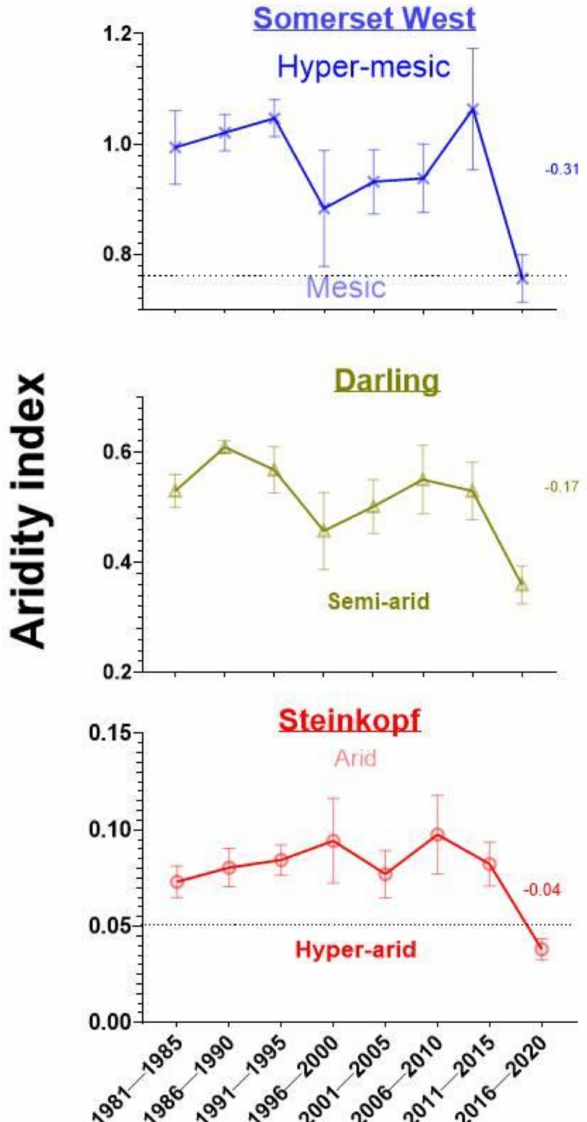
Figure 1. The aridity index for the last 40 years split into 5-year periods for three regions in South Africa, namely Somerset West (34.0757 ◦ S, 18.8433 ◦ E), Darling (33.3756 ◦ S, 18.3861 ◦ E) in the Western Cape and Steinkopf (29.2602 ◦ S, 17.7340 ◦ E) in the Northern Cape. Climate classification is according to Colantoni et al. [92]. Mean ±